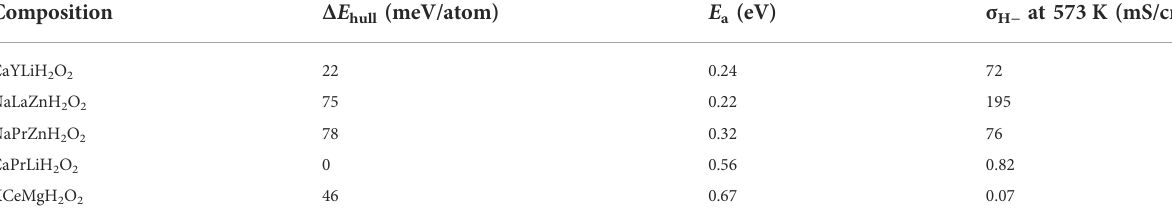
TABLE 4 Hydride conduction properties of the newly predicted A 1 A 2 BH 2 O 2 oxyhydrides.